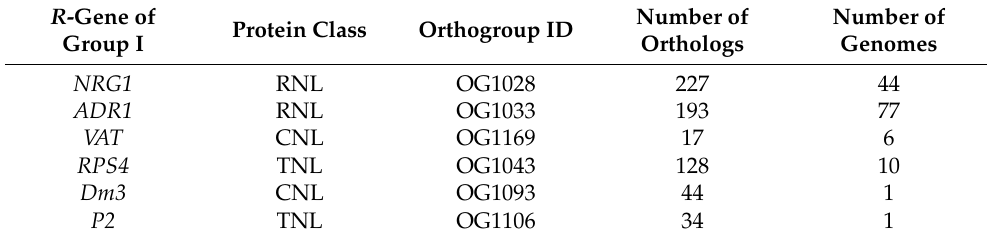
Table 2. Orthologous genes to R -genes group I reported in Figure 3. R -Gene